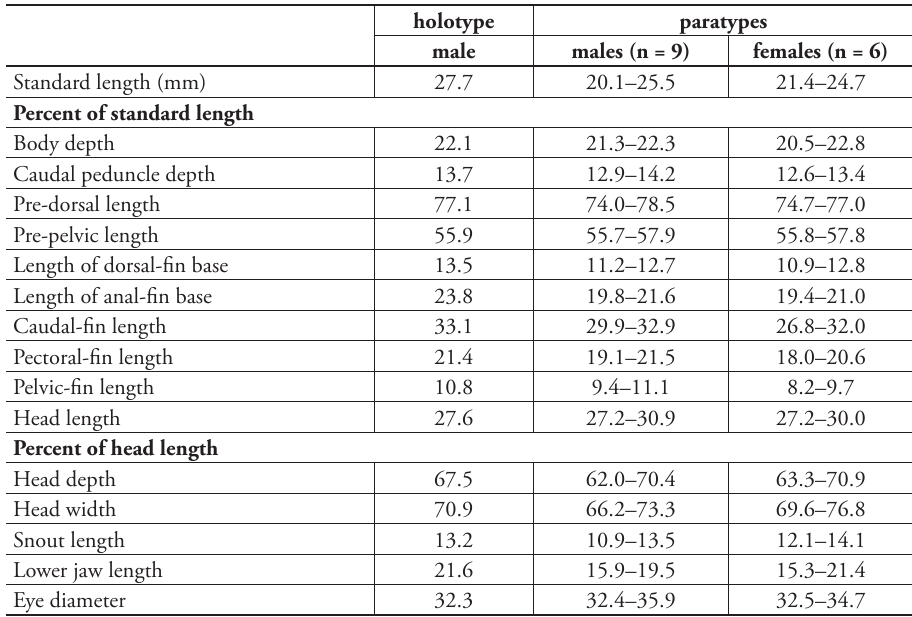
Figure 2. Melanorivulus ignescens sp. n., paratype, UFRJ 6876, female, 23.4 mm SL. Photograph by W.J.E.M. Table 1. Morphometric data of Melanorivulus ignescens .